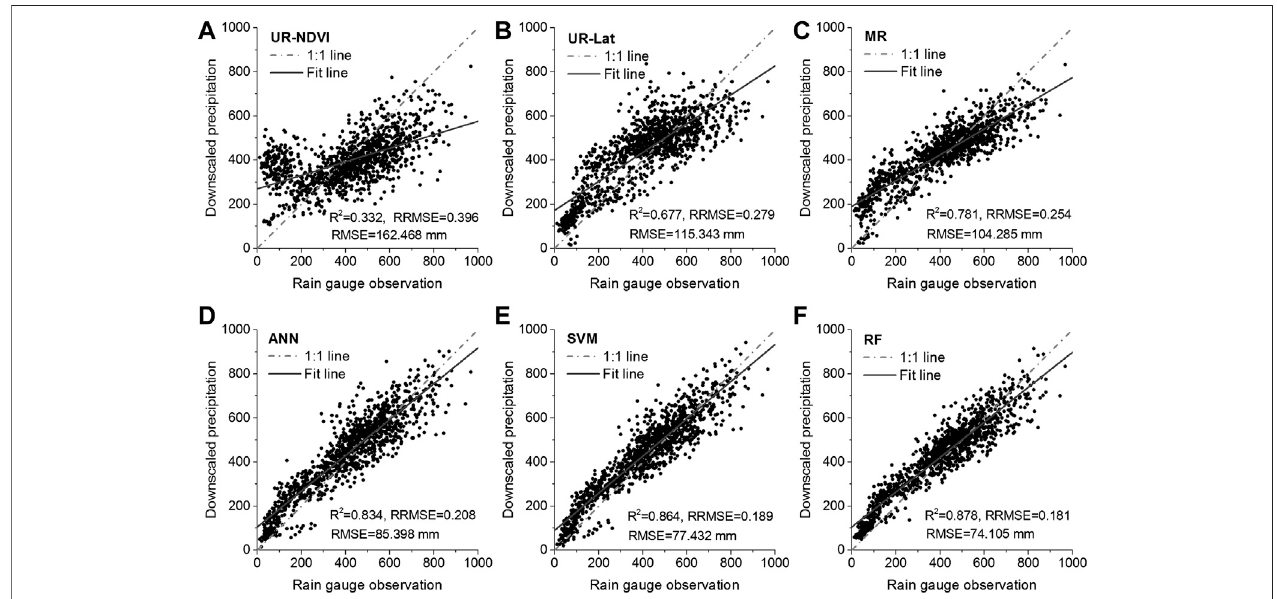
FIGURE8| Validationresultsofthedownscaled1 kmIMERGprecipitationwithoutresidualcorrectionusingtheraingaugeobservationsfrom2001to2015: (A – F) UR-NDVI, UR-Lat, MR, ANN, SVM, and RF.